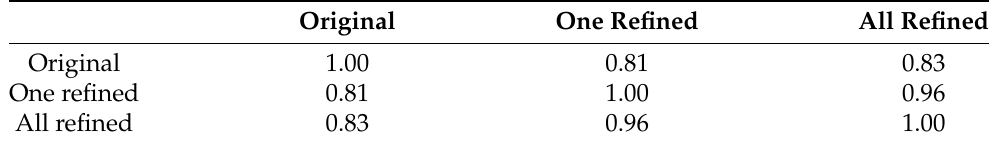
Table 2. Correlation coefficients (cohort